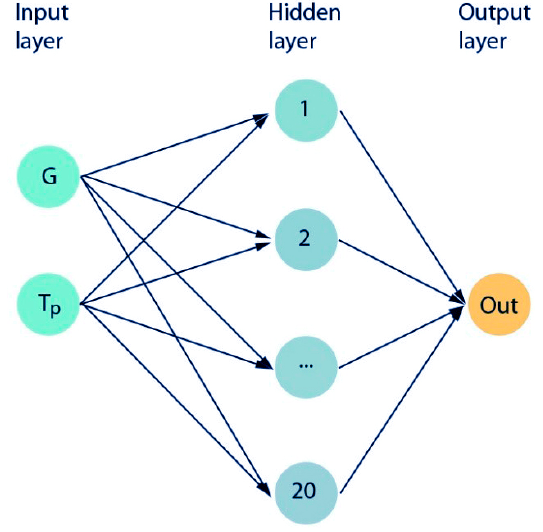
Figure 1. Structure of the feed-forward artificial neural network.